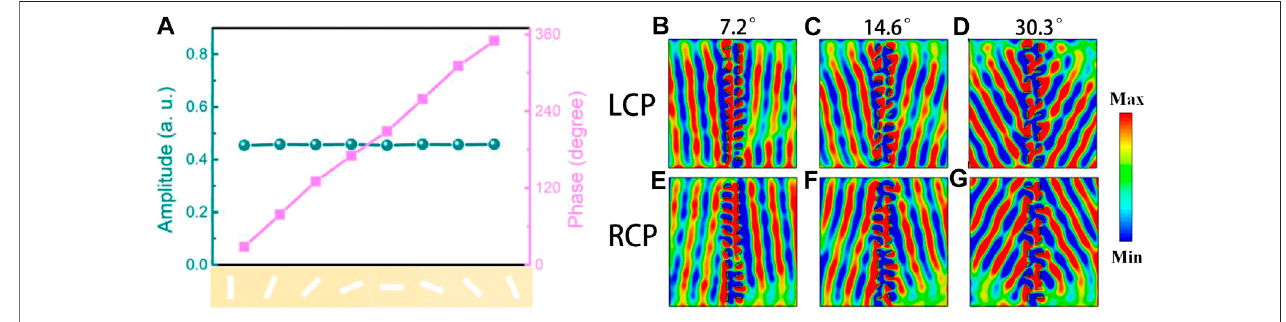
FIGURE 2 | Simulated E z - fi eld distributions of the ZTSW from a linear-phase-pro fi le structure under normal incidences of LCP with a (B) 7.2 ° , (C) 14.6 ° , and (D) 30.3 ° de fl ectedangle.Thecorresponding E z - fi elddistributionsoftheZTSWundernormalincidencesofRCPwitha (E) 7.2 ° , (F) 14.6 ° ,and (G) 30.3 ° de fl ectedanglewhile the geometry and rotation of the microslits were fi xed. (G) Simulated amplitude and phase shift of microslits shown at 0.49 THz.